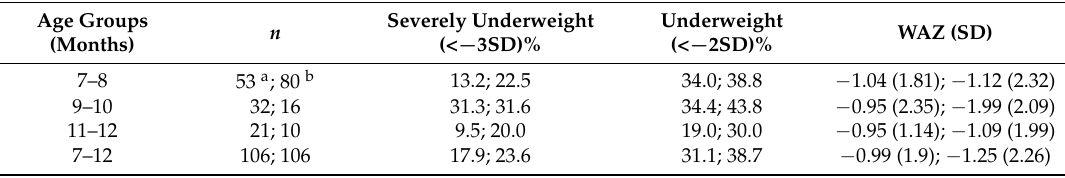
Figure 2. Food groups consumed by children determined using a 24 h recall period. Table 3. The prevalence of underweight in Hammanskraal and Lebowakgomo determined by Weight for Age (Z ‐ score).